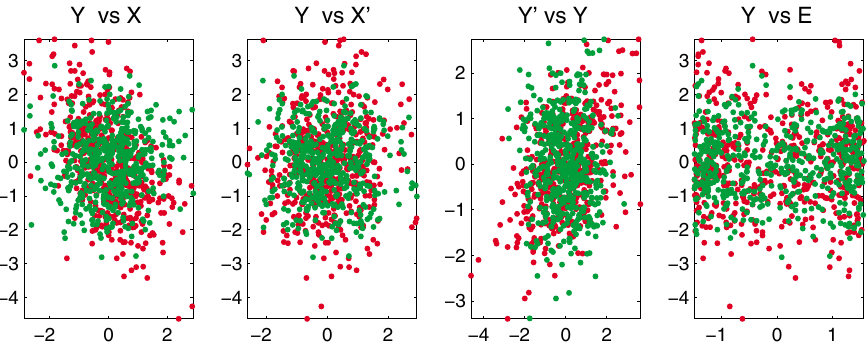
(cid:3) 1 : 00 , =(cid:3) x x 0